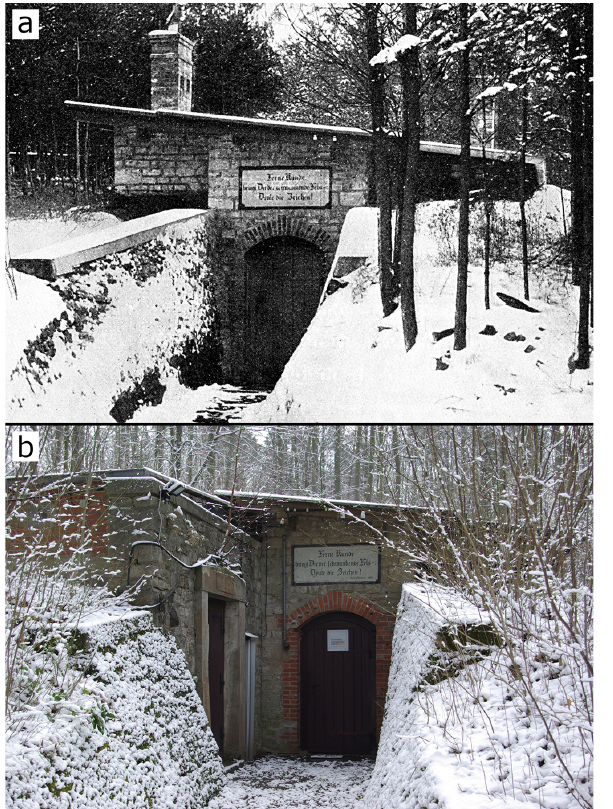
Figure 3. (a) Altes Erdbebenhaus circa 1905. The inscription by Emil Wiechert (Fig. 4) is found above the entrance. Undated picture taken and slightly modified from Wiechert (1906). (b) Erdbeben- warte with altes Erdbebenhaus and neues Erdbebenhaus (building to the left) in 2008. Photo: Udo